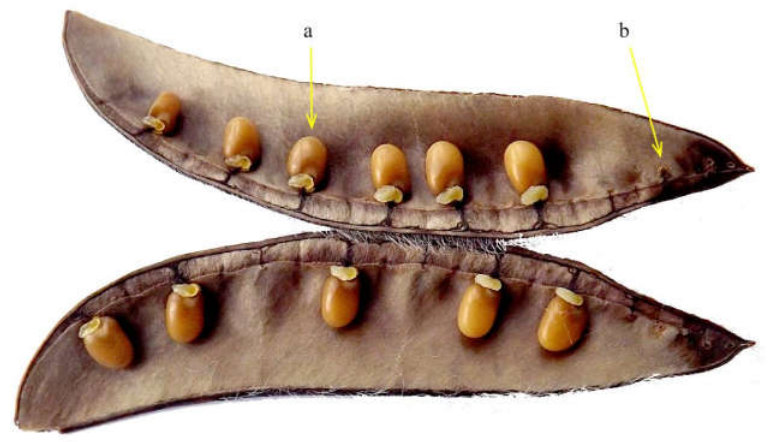
Figure 2. Opened pod of Cytisus scoparius with matured seeds ( a ) and aborted ovules ( b